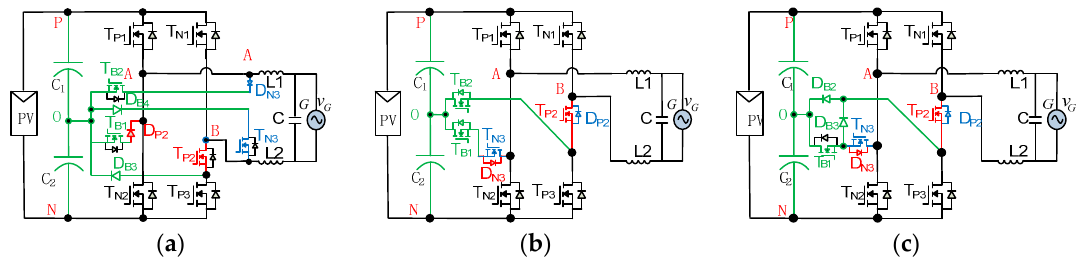
Figure 17. Direct Connection NPC topologies from M = 2, N = 2. ( a ) R4S2 (new); ( b ) R5S2-1 [47]; ( c ) R5S2-2 (new).